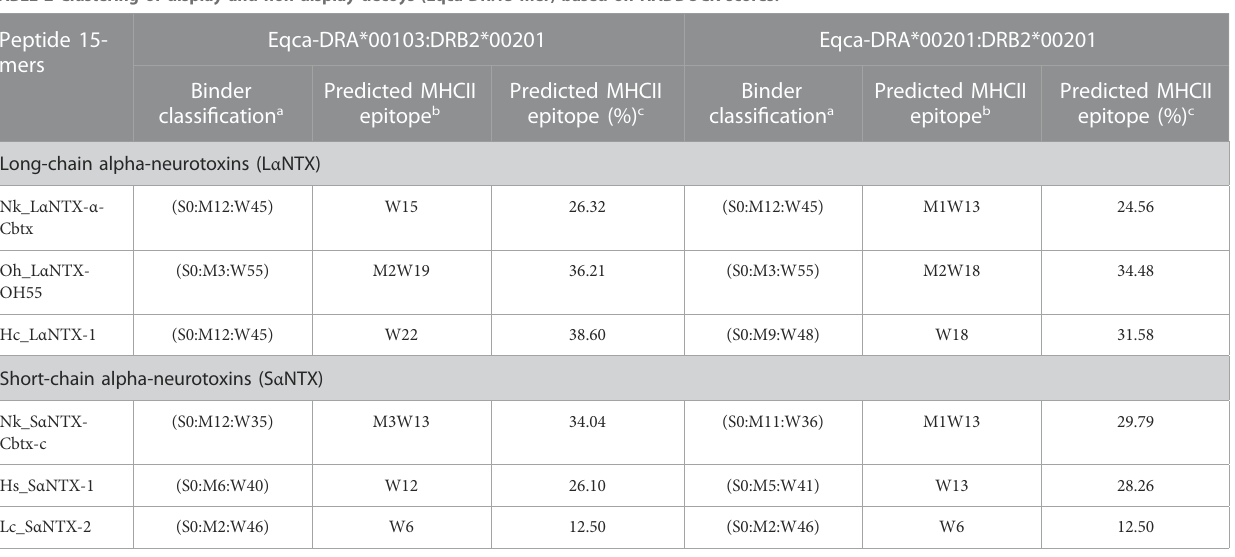
a 15-merpeptideswereclassi fi edinto “ strongbinder ” (S,HADDOCKscore ≤ − 230), “ moderatebinder ” (M,HADDOCKscore − 230to − 180),and “ weakbinder ” (W,HADDOCKscore ≥ − 180) based on the arbitrary binding thresholds. Thresholds are de fi ned based on the HADDOCK scores of standard and reference ligands (hemagglutinin and endogenous peptide A2). The numerical values indicate the number of binders. b 15-mer peptides that ful fi lled the de fi ned algorithms outlined in the present study (Section 2.4.2). The numerical values indicate the number of binders. c Relative percentage of 15-mer peptides with predicted MHCII epitopes over the total number of 15-mer peptides generated per examined α -NTX.